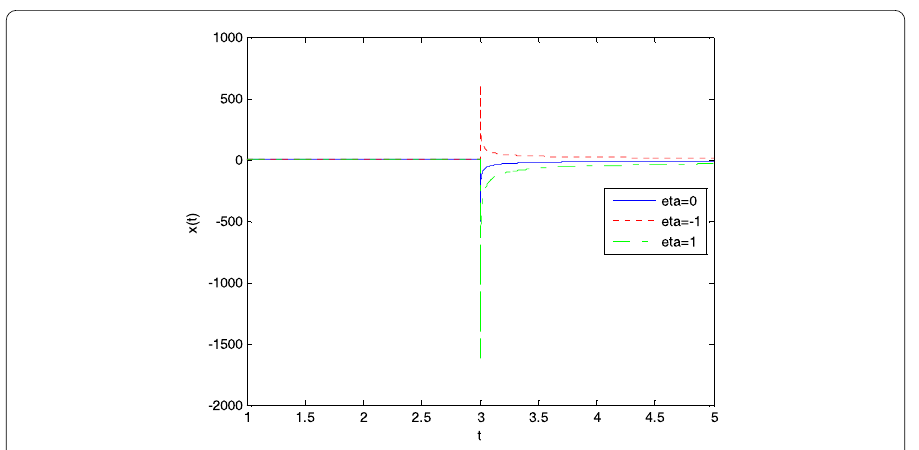
Figure 6 The solution trajectory of system (5.2) with ρ = 0.5